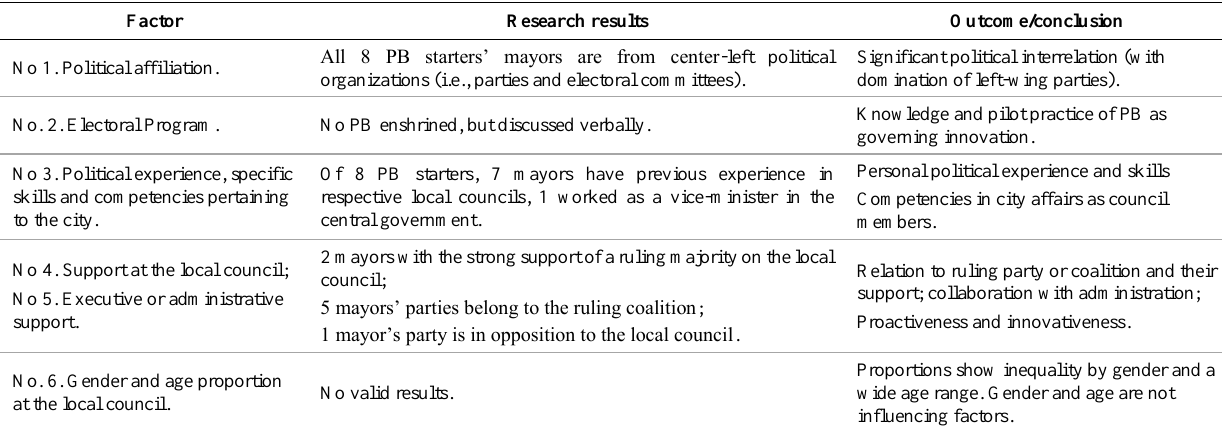
Table 4. Mayoral characteristics impacting PB resiliency in